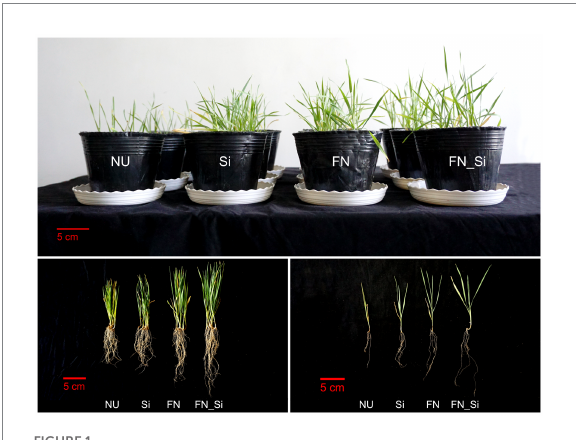
FIGURE 1 Morphology of wheat under salt-alkaline